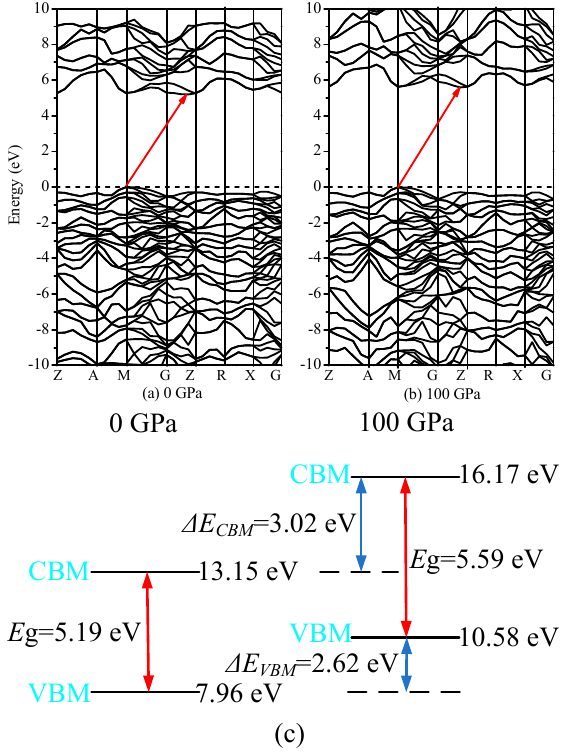
Figure 7. Electronic band structure for the I4 –carbon at ambient pressure ( a ) and 100 GPa ( b ); the calculated energy values of CBM and VBM under different pressures ( c ).